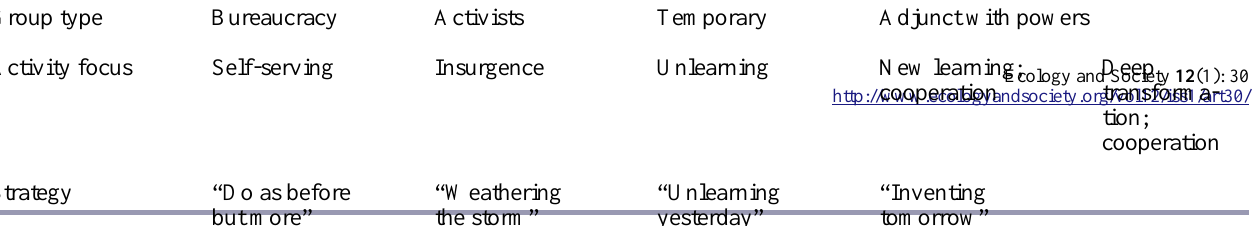
Table 3 . Attributes of human groups that seem to dominate activities in the four phases of the adaptive cycle of Holling (adopted from Holling and Sanderson 1996). This table represents a centrist view of primarily North American